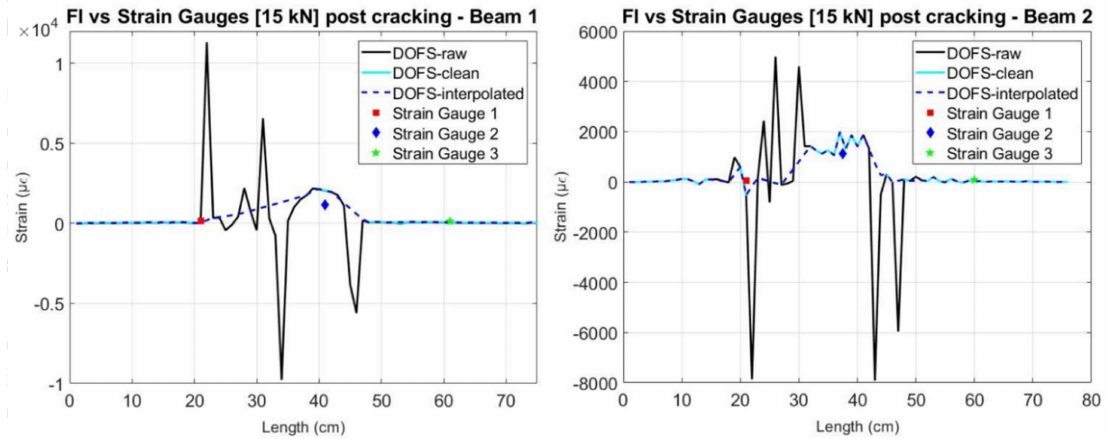
Figure 21. Comparison of the measured values before and after interpolation of the DOFS with the strain gauges for 15 kN—Beam 1 ( left ) and Beam 2 ( right